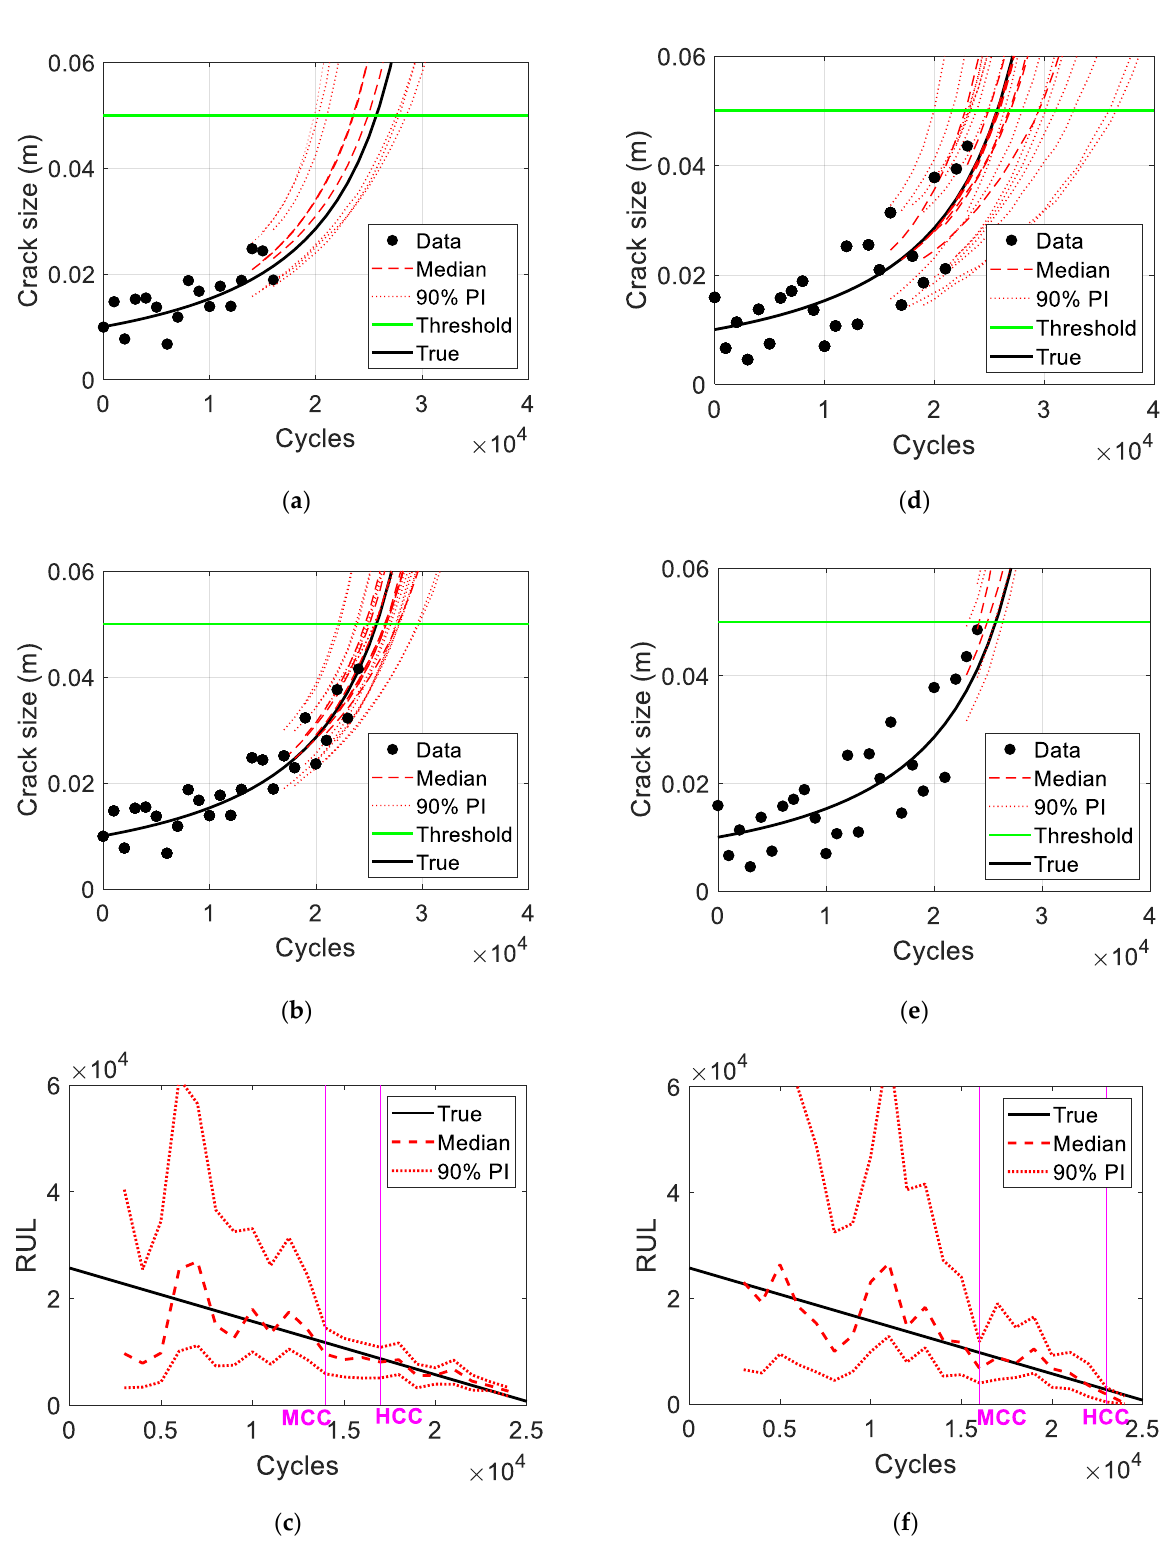
Figure 7. PIs and credibility criteria results: crack growth problem. ( a ) Medium level of noise, ( b ) large level of noise.